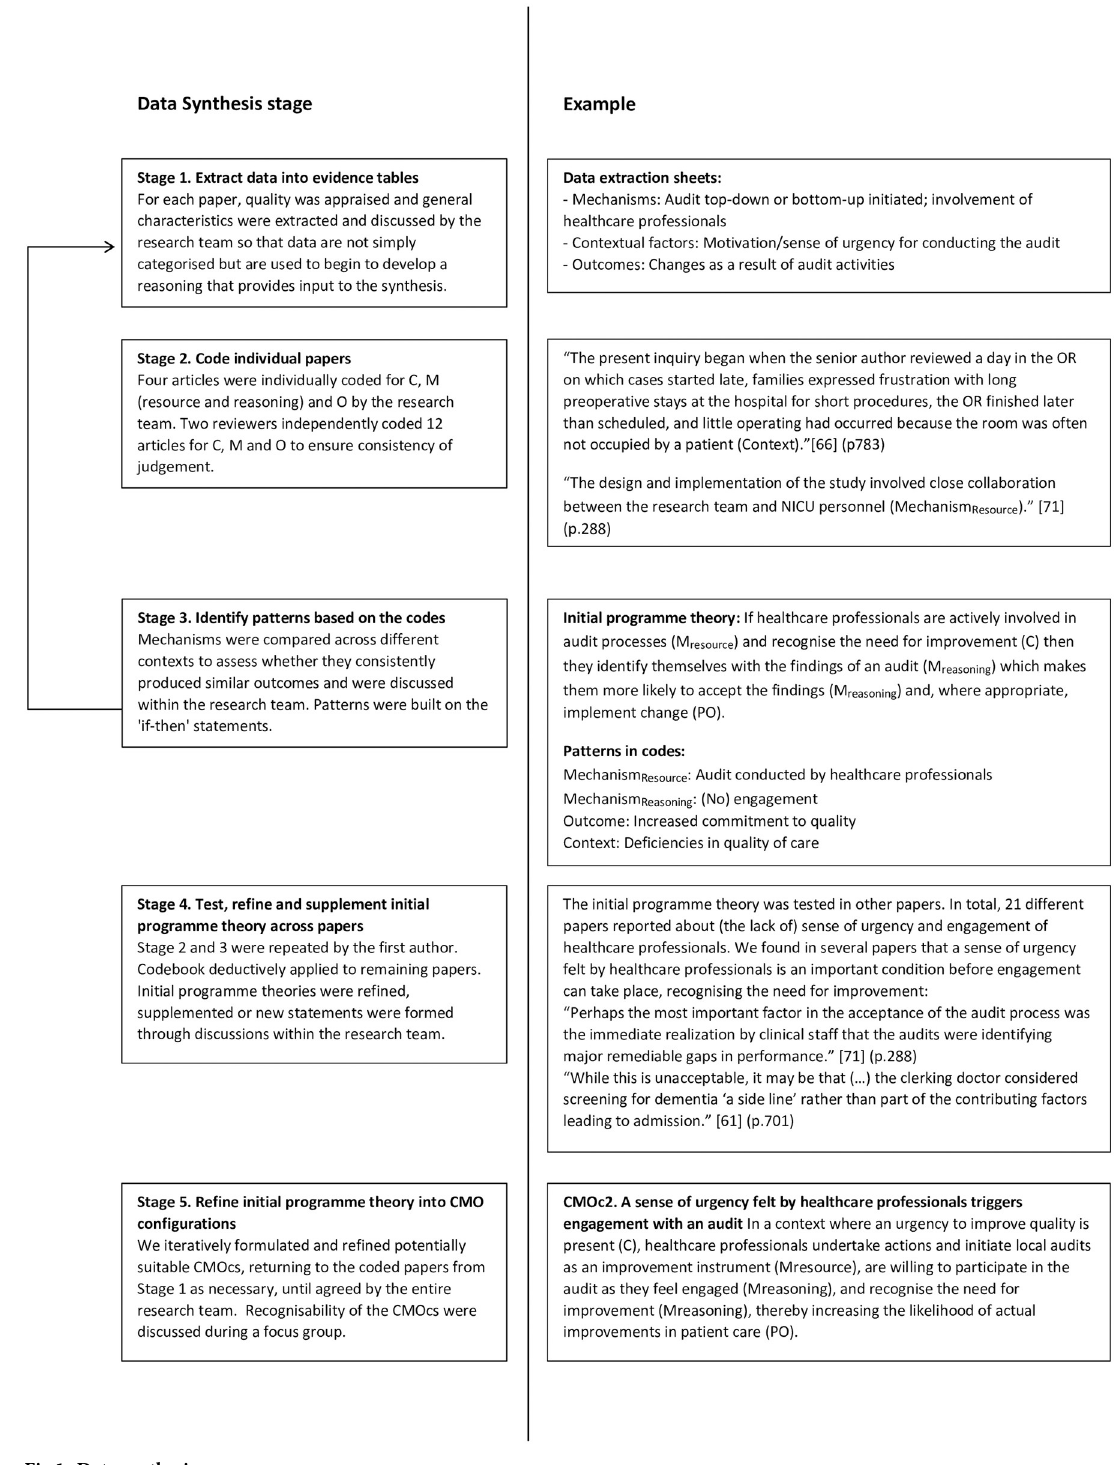
Fig 1. Data synthesis